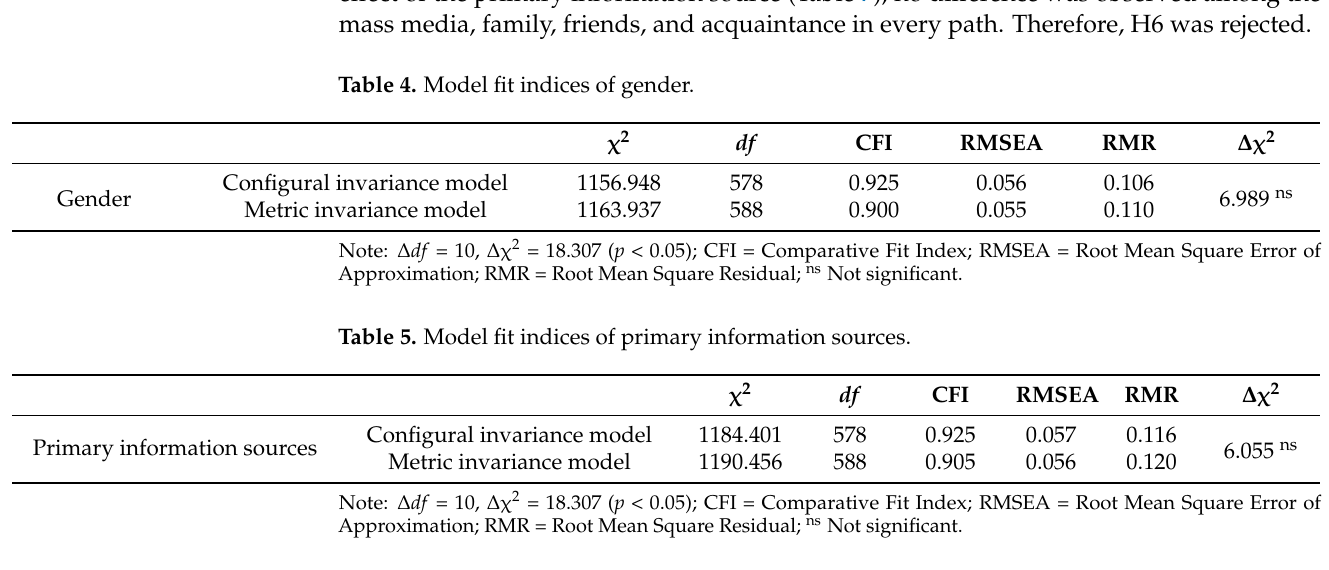
Table 6. Moderating effects on gender.